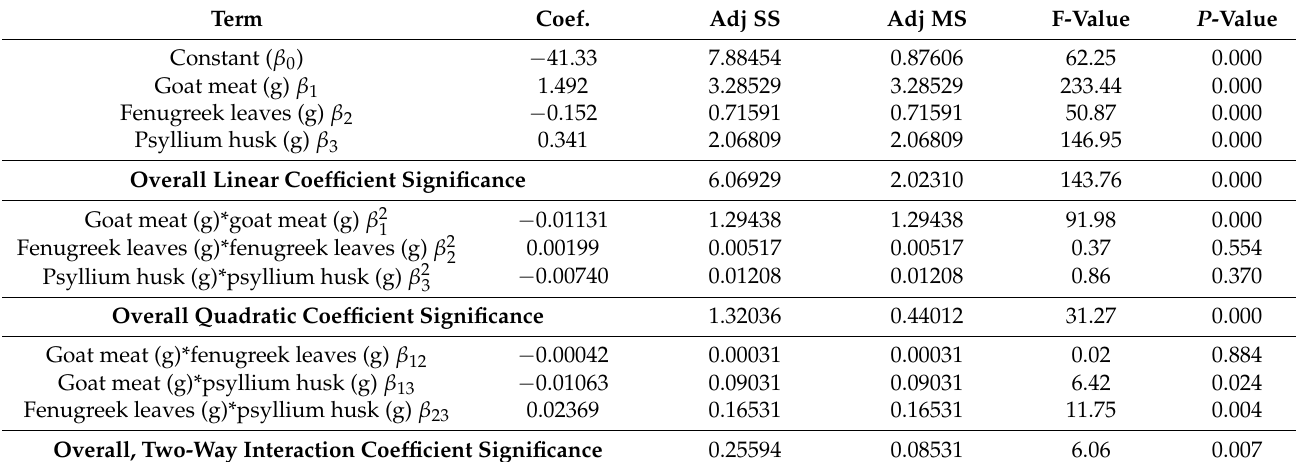
Figure 1. Comparison of observed and response model predictions. Table 2. ANOVA of the response